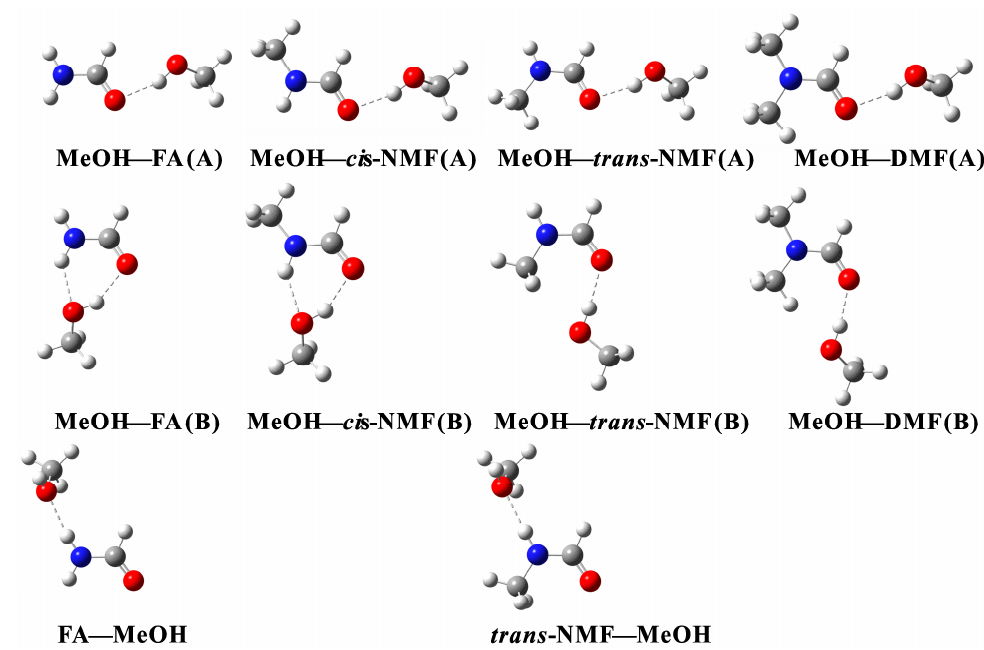
Figure 2. The stable structures of the MeOH–formamide and formamide–MeOH complexes obtained at the B3LYP-D3/aug-cc-pVTZ level; The O–H ∙∙∙ O and N–H ∙∙∙ O hydrogen bonds are presented by the dotted lines; FA: formamide; NMF: N -methylformamide; DMF: N , N -dimethylformamide; MeOH: